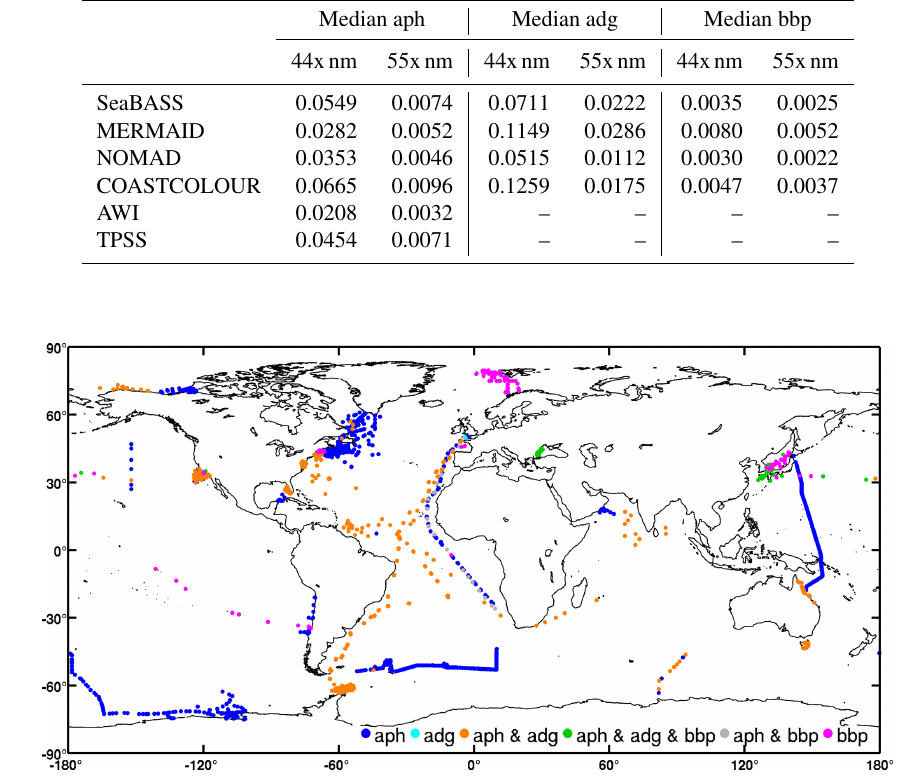
Figure 14. Global distribution of observations of inherent optical properties (algal pigment absorption coefficient aph, detrital plus CDOM absorption coefficient adg, and particle backscattering coefficient bbp) in the final table.